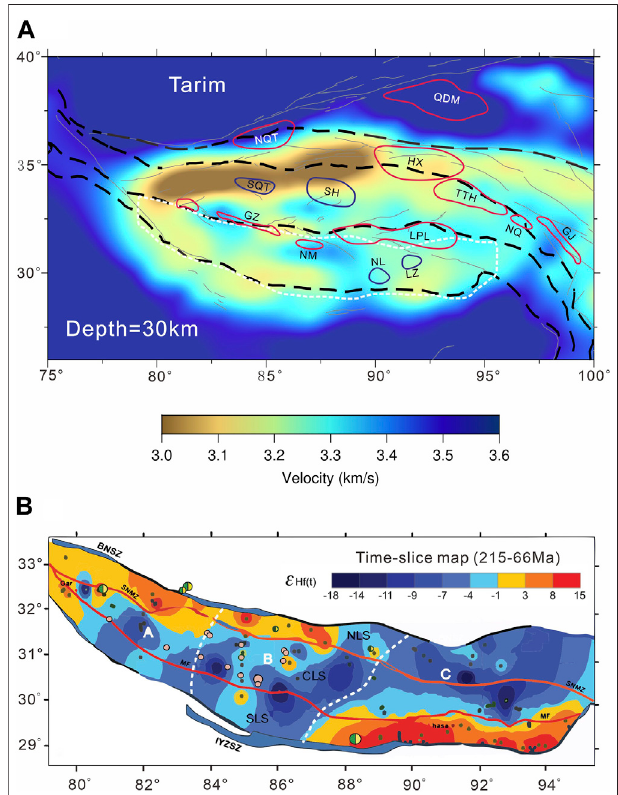
FIGURE 2 | Shear wave velocity of the crust and Hf isotopic mapping. (A) Shear wave velocity at a 30 km depth in the region shown in Figure 1 (Yang et al., 2012). Red curves delineate the hinterland basins with a relatively fast velocity. Blue curves delineate the hinterland basins with a relatively slow velocity. (B) Hf isotopic mapping showing the spatial variation of zircon ε Hf(t) values for felsic igneous rocks in the Lhasa terrain (Hou et al., 2015). The region is outlined by a white dashed curve in (A) . SLS, southern Lhasa subterrane; CLS, central Lhasa subterrane; and NLS, northern Lhasa